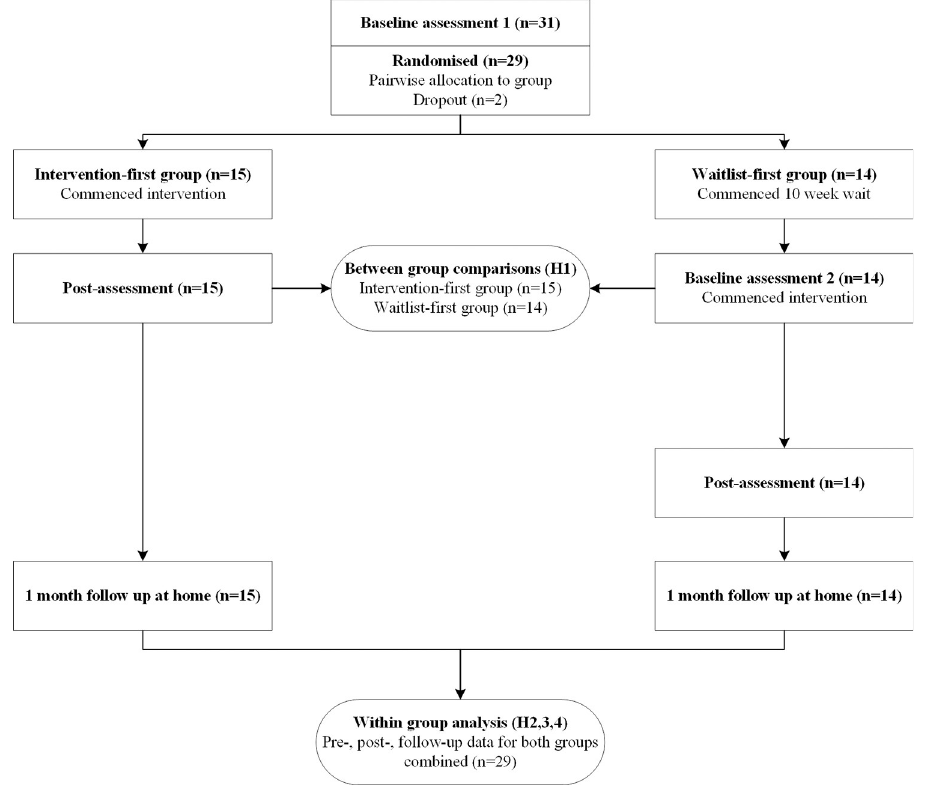
Fig 1. CONSORT participant flow